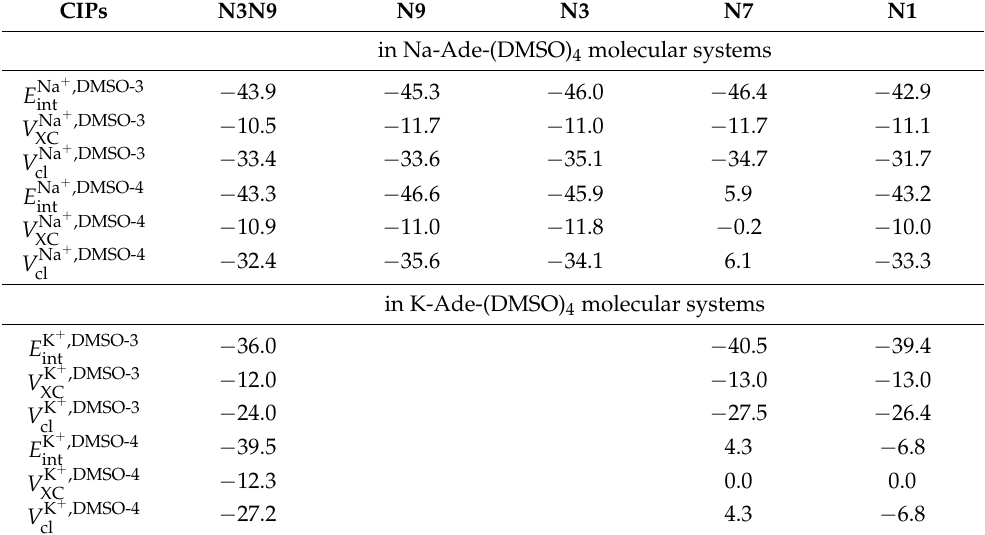
Table 6. The total interaction energy, E M + ,DMSO V M , components computed for DMSO-3 and DMSO-4 solvent molecules in the indicated cl M-Ade-(DMSO) 4 molecular systems. All values in kcal mol − 1